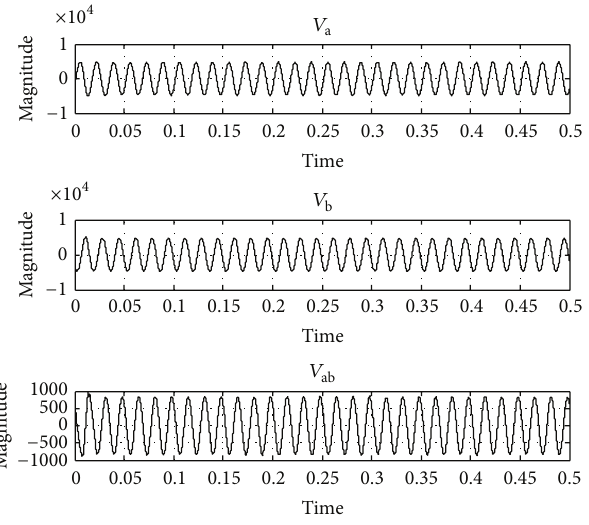
Figure 9: Output waveform with UPQC connected controlled by ACO-FLC technique.